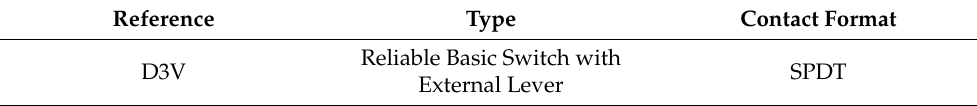
Table 2. Characteristics of the waste bin mechanical sensor.